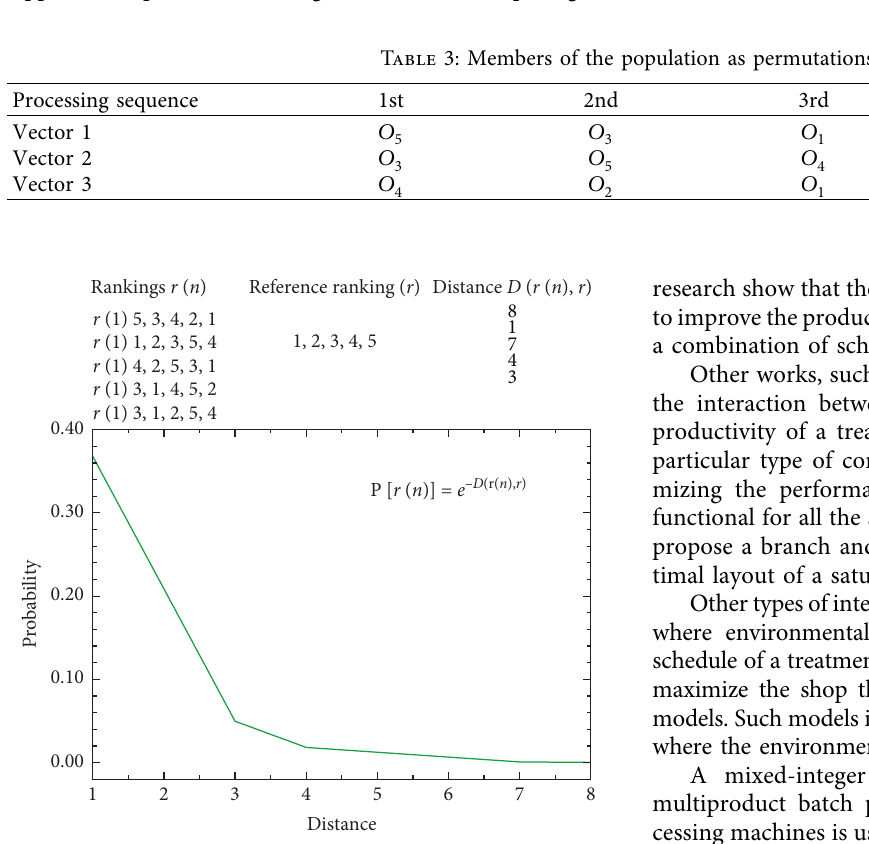
Figure 2: Exponential distribution using a distance between